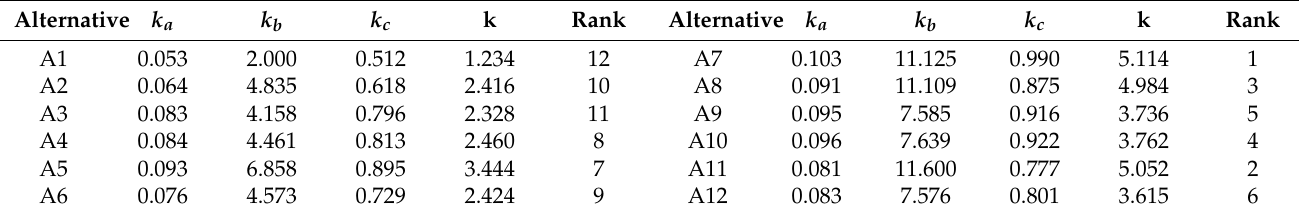
Table 9. Rank calculations using CoCoSo (Lambda = 0.5).